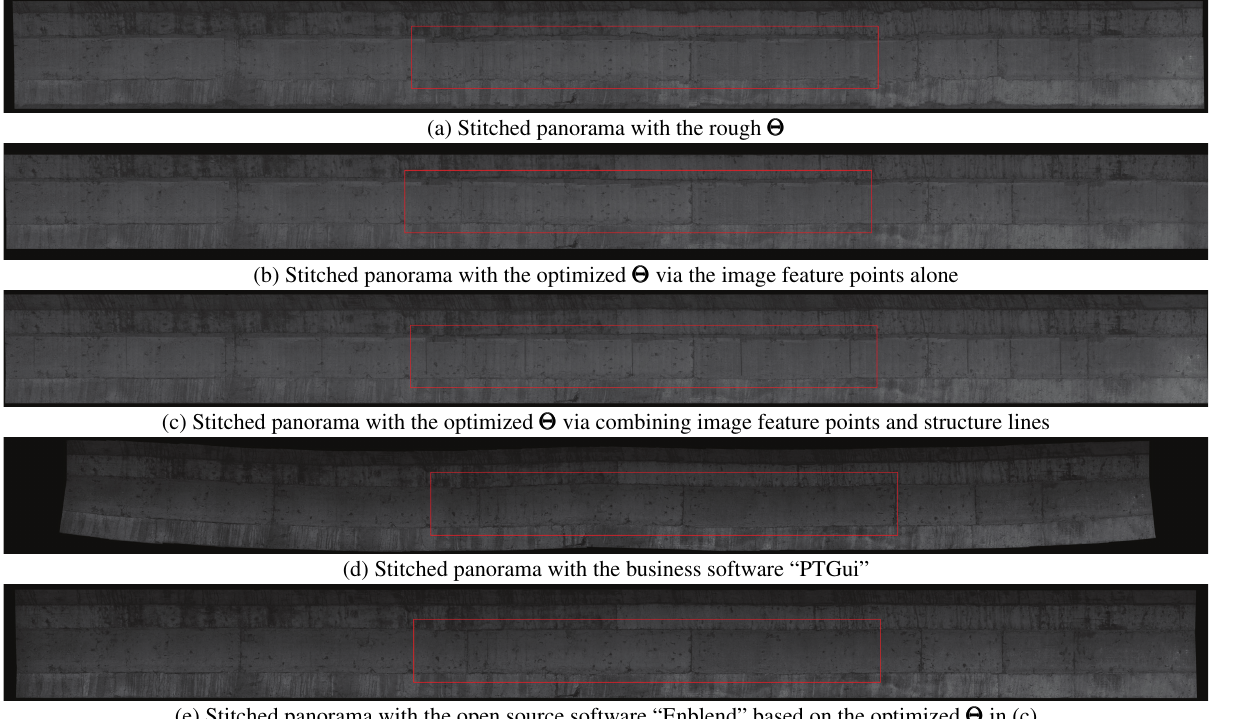
(b) Stitched panorama with the optimized (cid:2)(cid:2)(cid:2) via the image feature points alone